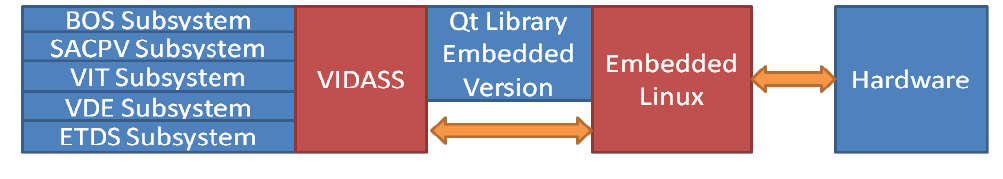
Figure 14. Proposed system software